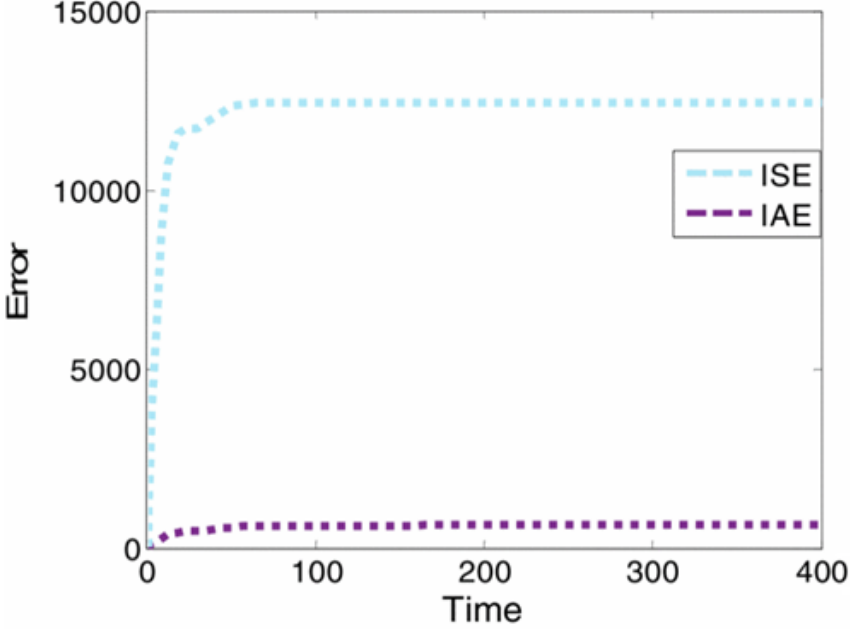
Figure 8. Error response plot of PID controller in terms of time and error . PID controllers with dead time (WD) and without dead time (WOD) represent the response in the time domain, with integral square error (ISE) and integral absolute error (IAE).